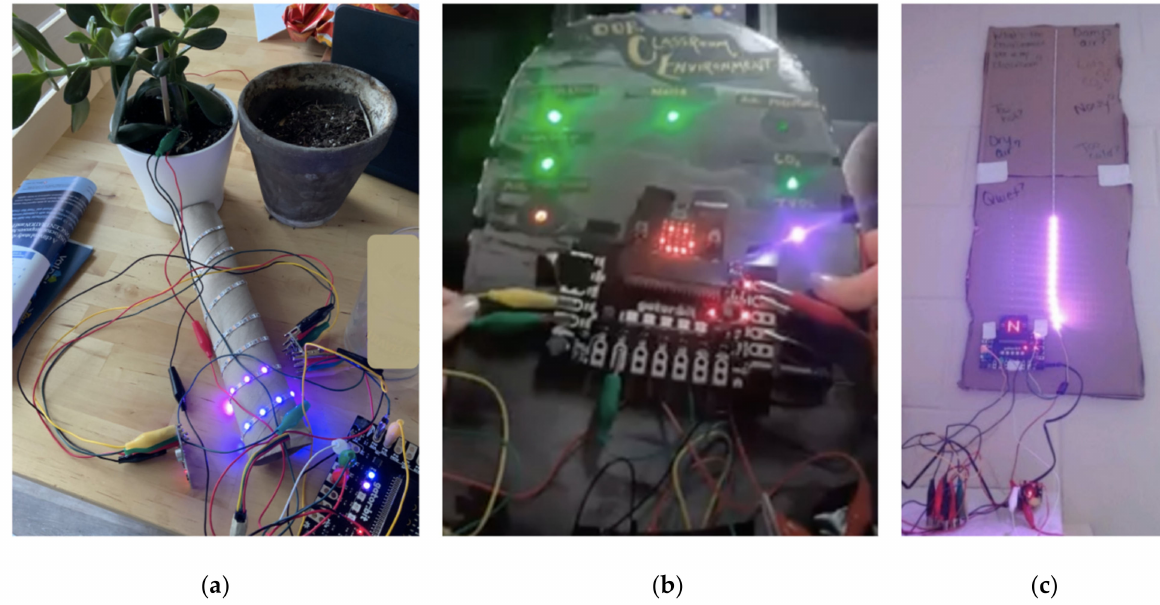
Figure 2. Three teacher-built DaSH examples: ( a ) monitoring a plant’s soil moisture and ( b , c ) monitoring the classroom environment (temperature, humidity, carbon dioxide, sound